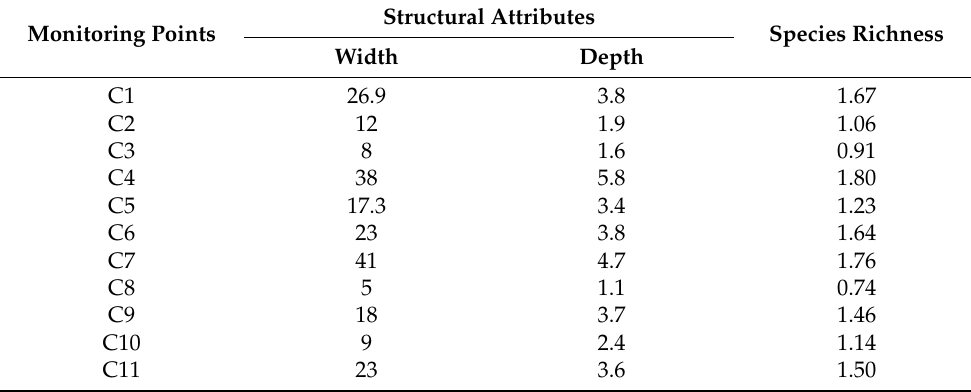
Table 3. Fish species richness of channel elements.